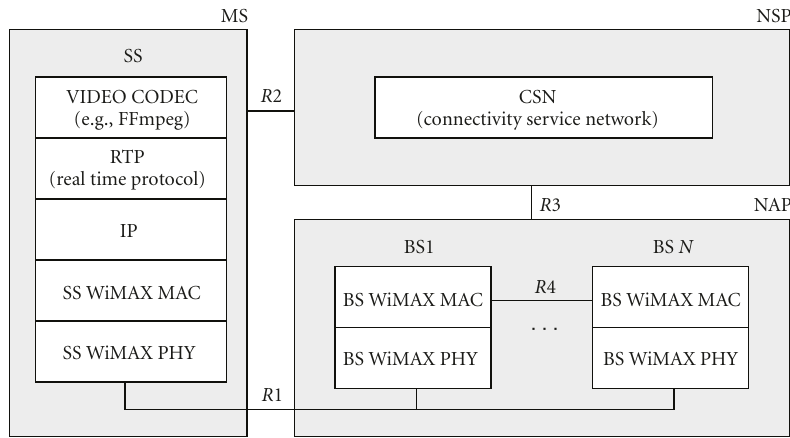
Figure 11: Example architecture which can be simulated with the WiDe module. Mobile station is what has been called subscriber station (SS) from IEEE standard nomenclature, the network access provider (NAP) is composed by the set of functionalities to manage a connection from radio point of view with the SSs (therefore can be a single BS or a set of them) and the network service provider (NSP) is the entity in charge of managing the incoming requests of connectivity and negotiating the service